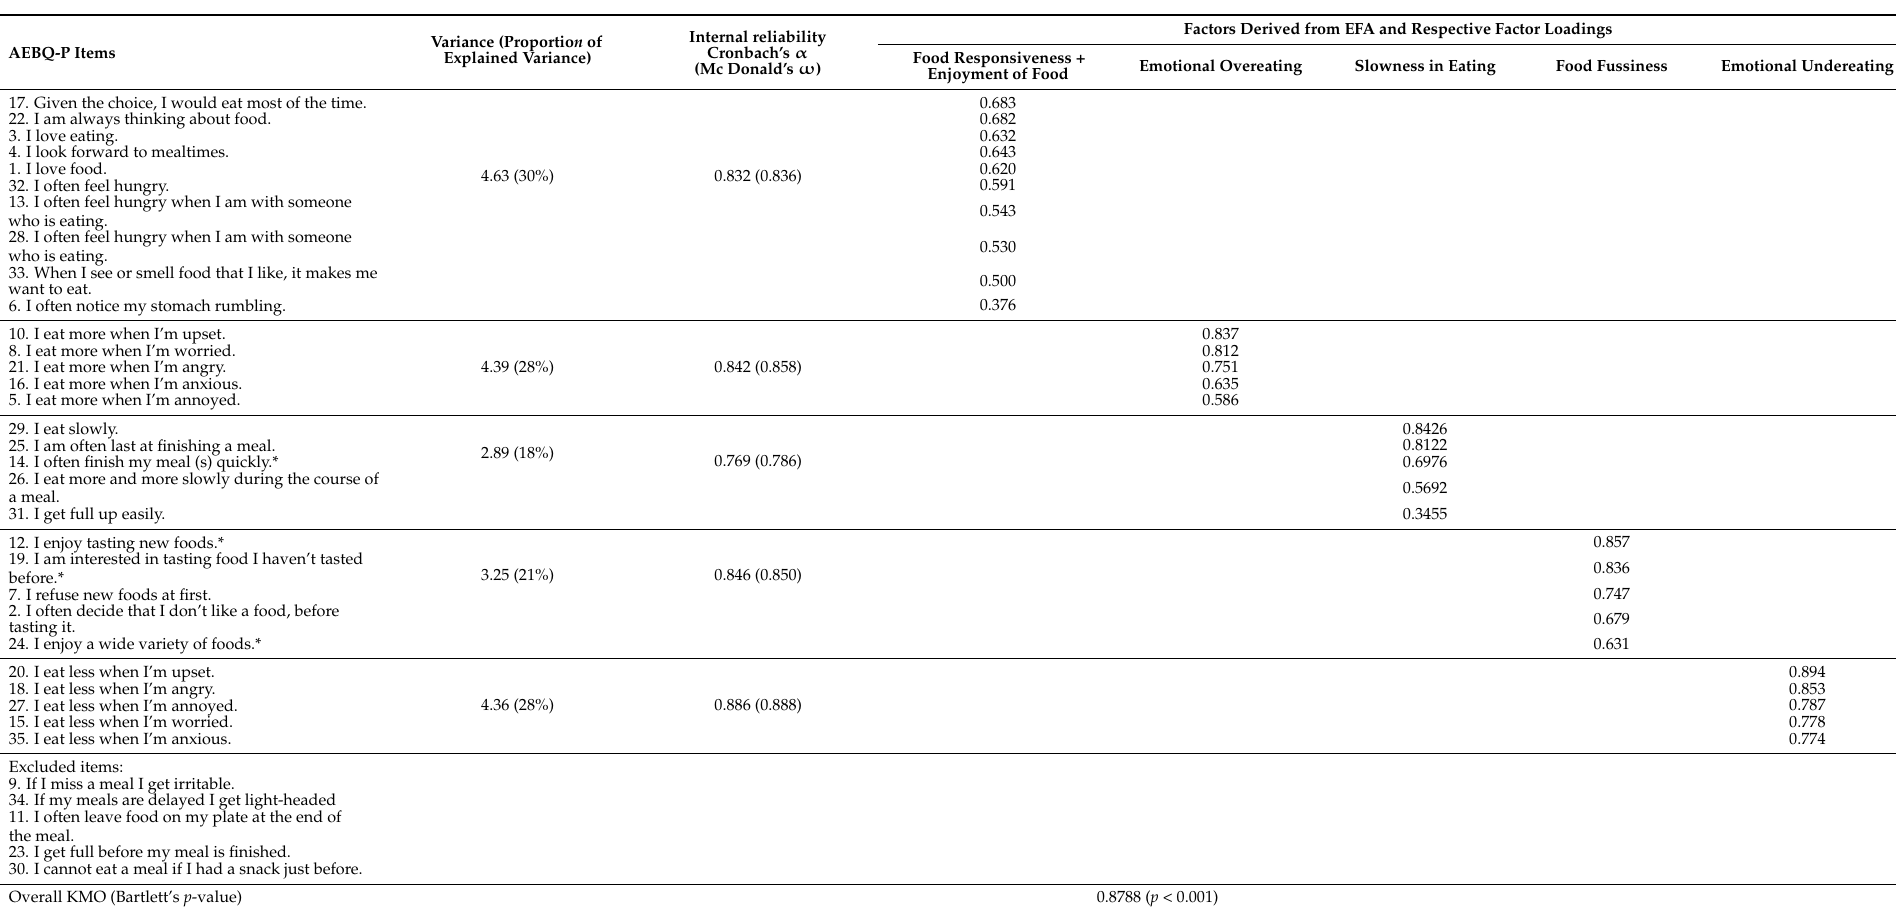
Table 3. Items, factor loadings and internal consistency of the AEBQ-P among Portuguese adolescents of 13 years